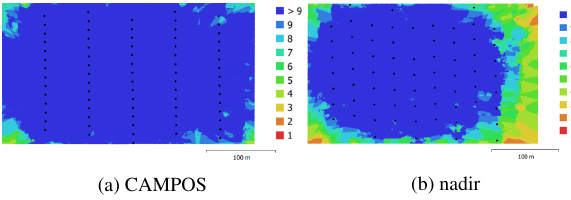
Figure 12. Locations and overlap of photos with each method.